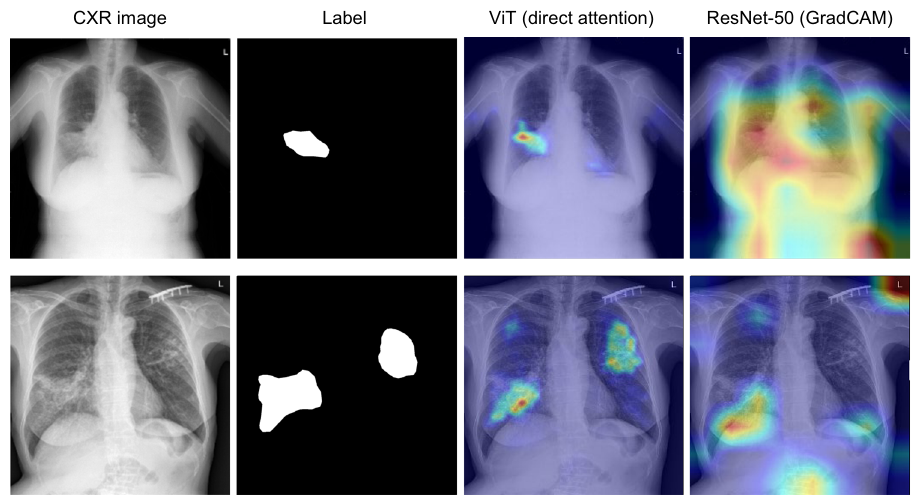
Fig. 6 Exempli fi ed tuberculosis lesion localization with attention by Vision Transformer (ViT) and convolutional neural network (CNN)-based models. The direct visualization of ViT attention offers better localization of the target lesion than indirect attention visualization of CNN-based models using Gradient-weighted Class Activation Mapping (GradCAM).